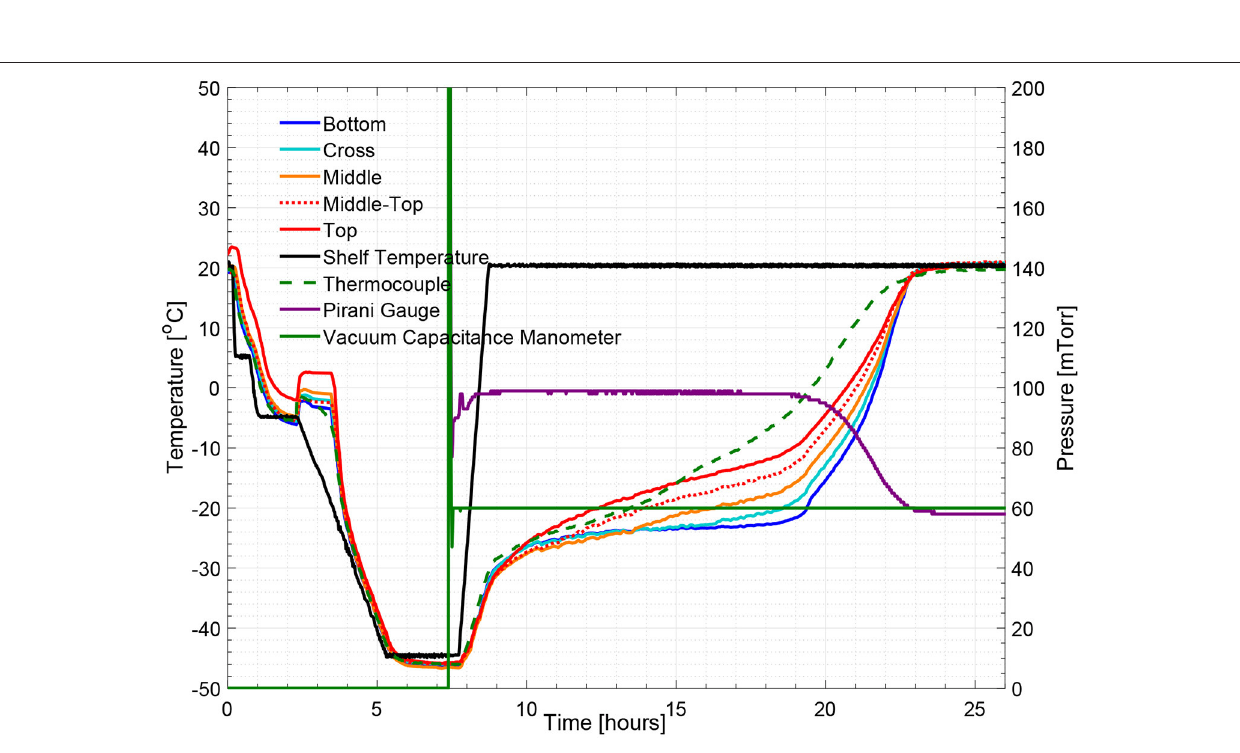
Frontiers in Chemistry |